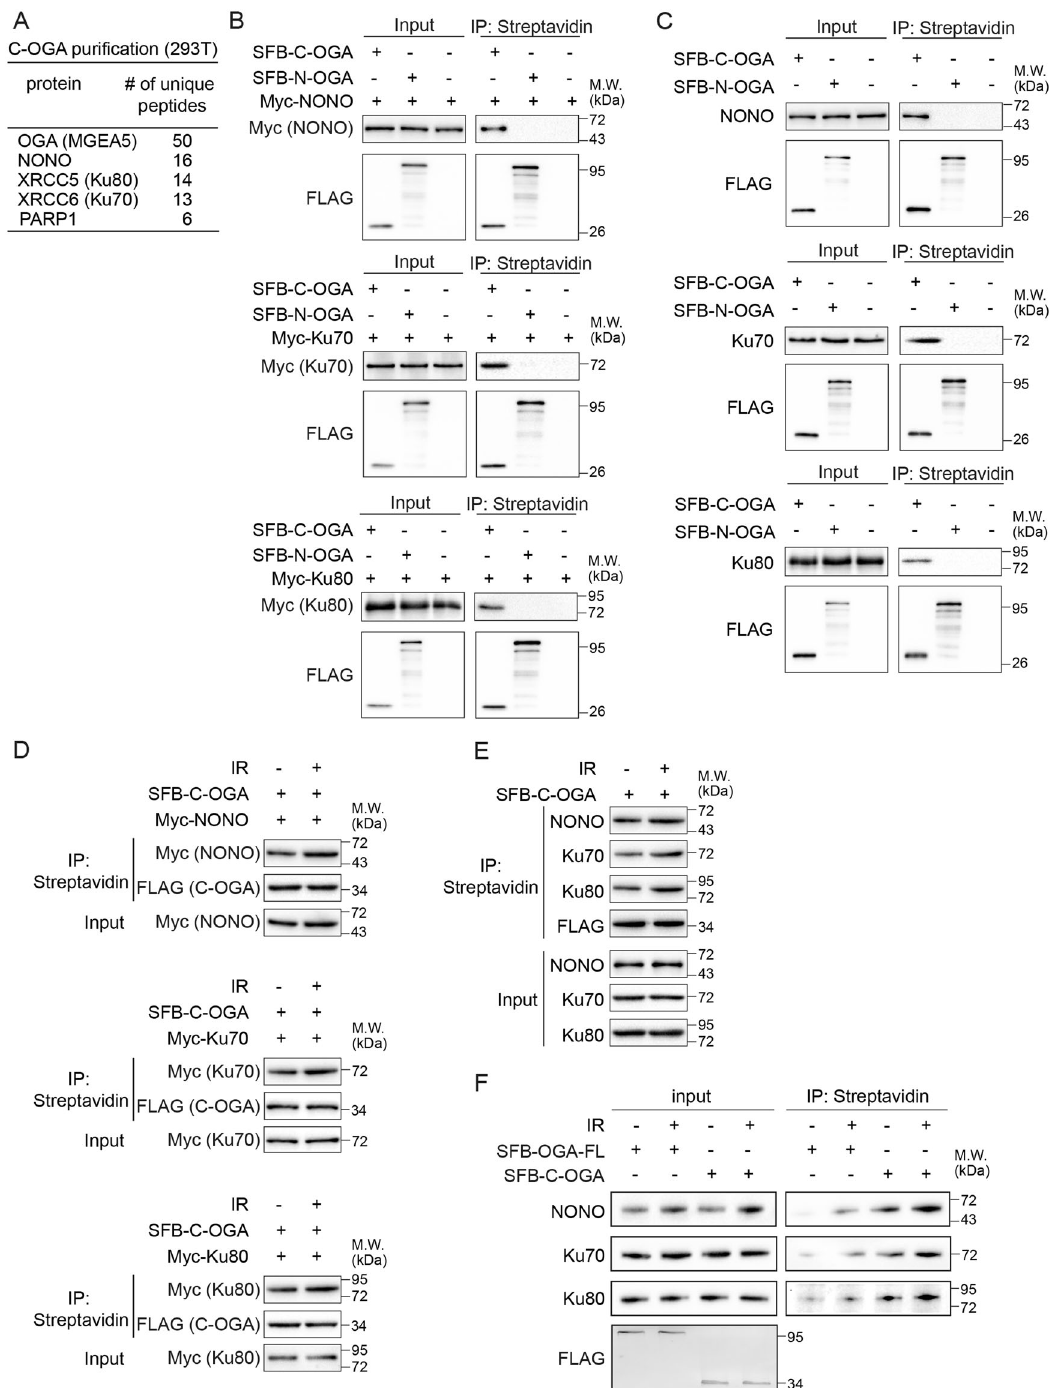
Fig. 3 OGA associates with NONO and the Ku70/80 complex. A The list of proteins that were identi fi ed from the HAT domain of OGA (C- OGA) af fi nity puri fi cation and mass spectrometry. B , C The HAT domain of OGA (C-OGA) interacts with exogenous and endogenous NONO and the Ku70/80 complex. Myc-NONO and SFB-C-OGA or SFB-N-OGA were expressed in 293T cells. When endogenous NONO and the Ku70/ 80 complex were examined, only N-OGA or C-OGA was expressed in 293T cells. Cells were lyzed with NETN300 buffer. Cell extracts were examined by IP and western blot with indicated antibodies. D , E The interactions between the HAT domain of OGA (C-OGA) and NONO or the Ku70/80 complex were increased following IR treatment. Indicated constructs were expressed in 293T cells, and the cells were treated with 10 Gy of IR. The cell extracts were examined by IP and Western blot with indicated antibodies. SFB vector stands for SBP-FLAG-S tandem tag vector. F The interactions between the HAT domain of OGA (C-OGA) or OGA-FL and endogenous NONO or the Ku70/80 complex. C-OGA or OGA-FL was expressed in 293T cells, and the cells were treated with or without 10 Gy of IR. The cell extracts were examined by IP and Western blot with indicated